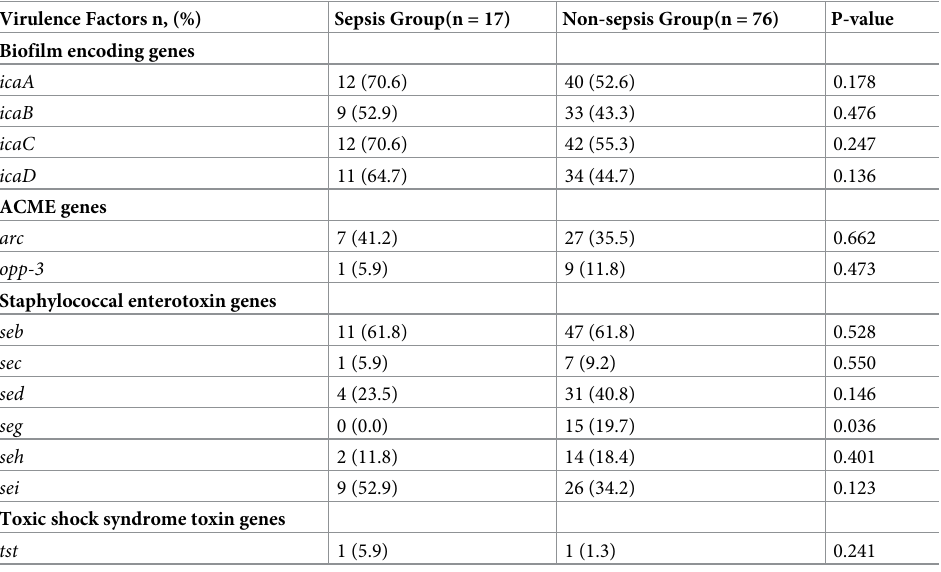
were positive for four genes, icaA , icaB , icaC and icaD , seven (7.5%) isolates were positive for three genes i caA , icaC and icaD , eight isolates (8.6%) were positive for two genes, icaA and icaC and three isolates (3.2%) were positive for either icaA , icaB , or icaC . Twenty S . epidermidis iso- lates were negative for all tested biofilm forming genes. Although the prevalence of biofilm for- mation genes was higher in the sepsis than in the non-sepsis group, the data presented in Table 4 showed no significant differences between sepsis and non-sepsis groups. Detection of the arginine catabolic mobile element (ACME) in CoNS isolates The distribution of the ACME genes, arc and opp-3 , among the 93 CoNS isolates is summa- rized in Table 4. In total, arc was detected in 34 (38.2%) isolates consisting of 31 S . epidermidis , Table 4. Biofilm production and genetic determinant of virulence factors in 93 blood isolates of different CoNS species obtained from neonates (Sepsis group vs Non-sepsis